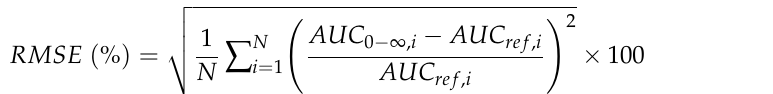
Table 1. Dosing regimen and scheduled sampling time in patients with various degrees of renal function. (mL/min)